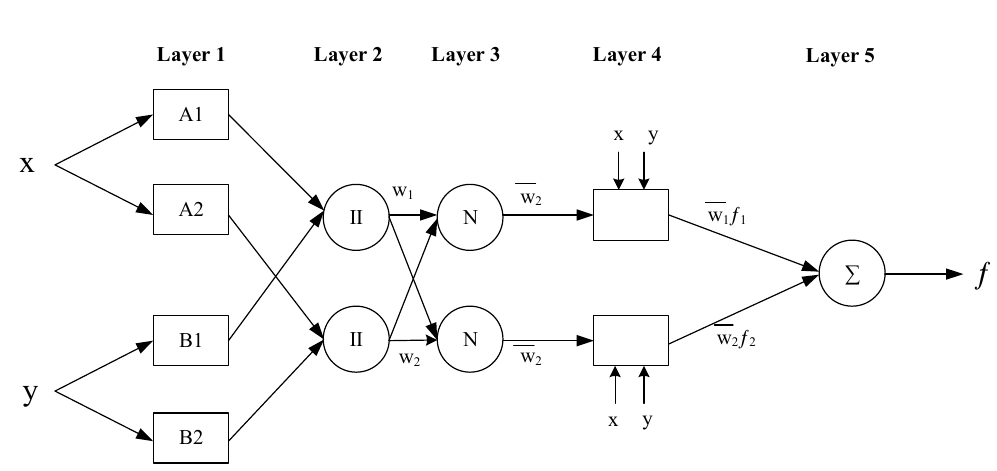
Figure 1. A basic structure of the adaptive neuro-fuzzy inference system (ANFIS) model.